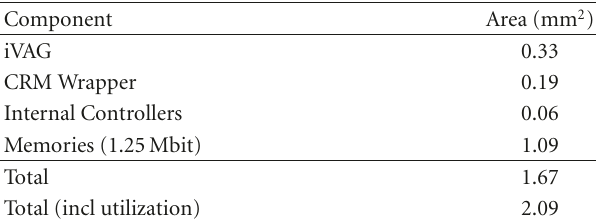
Table 10: Interleaver CMOS065 Area